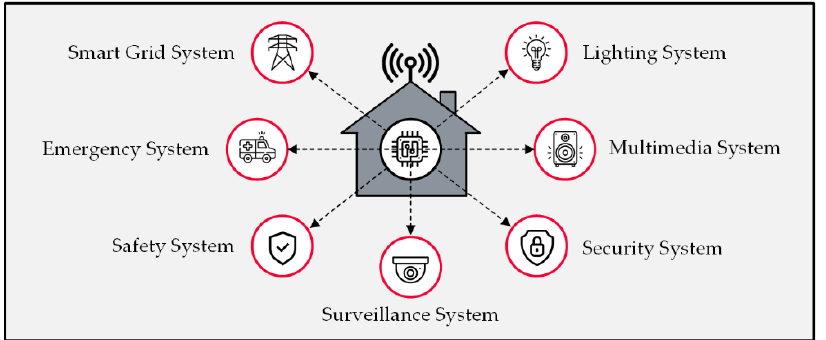
Figure 1. Smart home applications.